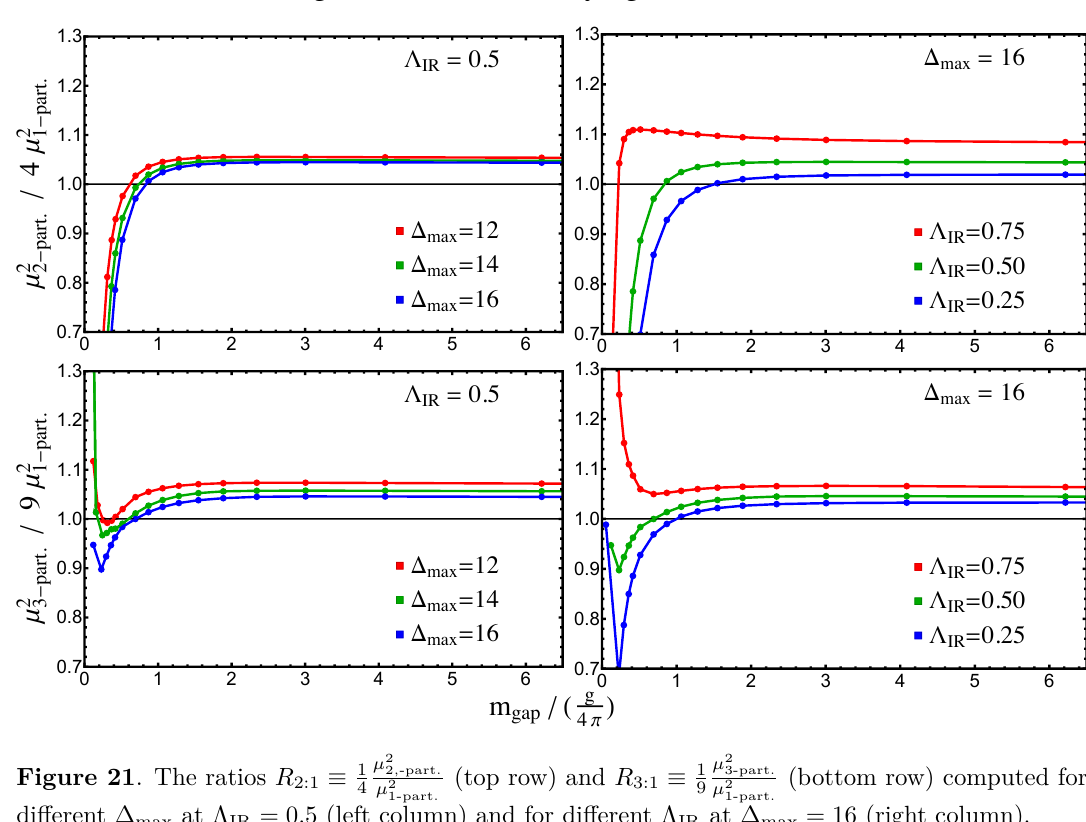
Figure 21 . The ratios R 2:1 ≡ 1 different ∆